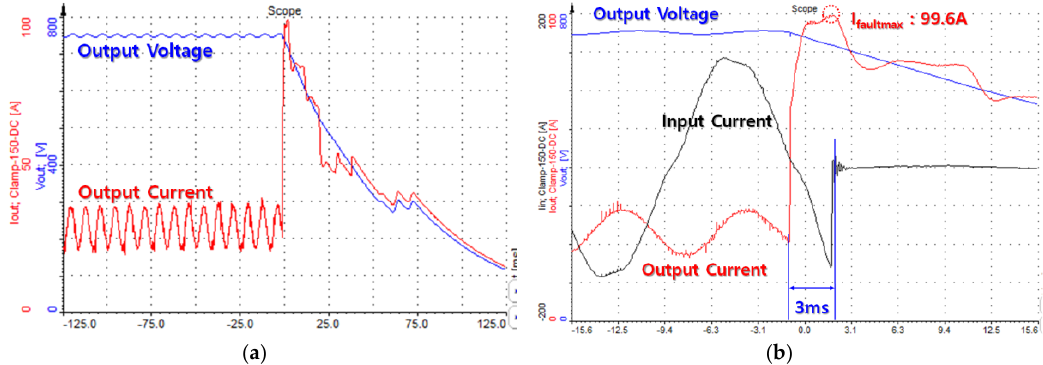
Figure 6. Wave resulting from the short circuit test of the AC/DC power converter. ( a ) Waveform when a short circuit occurs. ( b ) Enlarged waveform when a short circuit occurs.